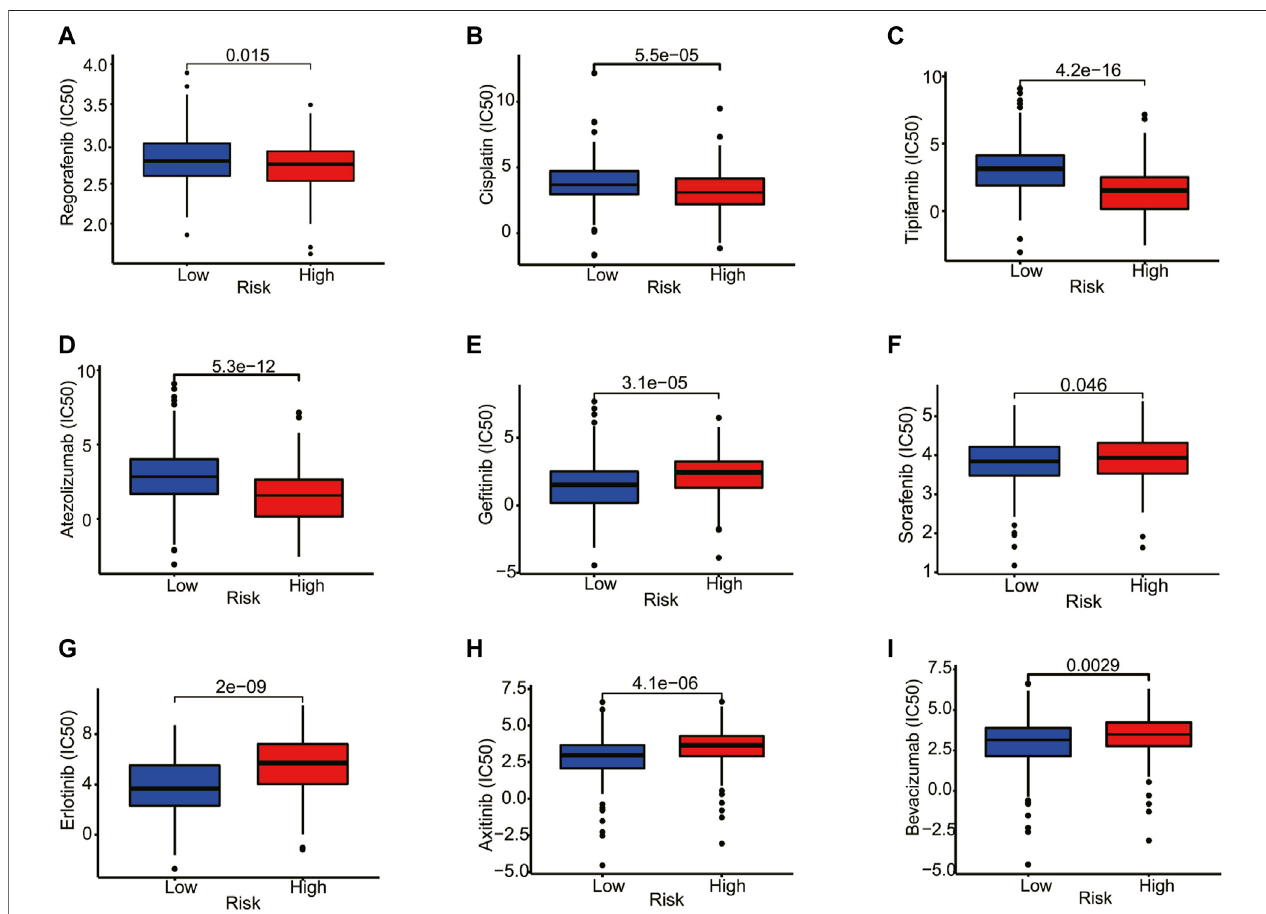
FIGURE 9 | Correlation analysis between the estimated IC 50 values of chemotherapy drugs and the risk score in HCC patients from the TCGA database. (A) Regorafenib, (B) Cisplatin, (C) Tipifarnib, (D) Atezolizumab, (E) Ge fi tinib, (F) Sorafenib, (G) Erlotinib, (H) Axitinib, (I) Bevacizumab.